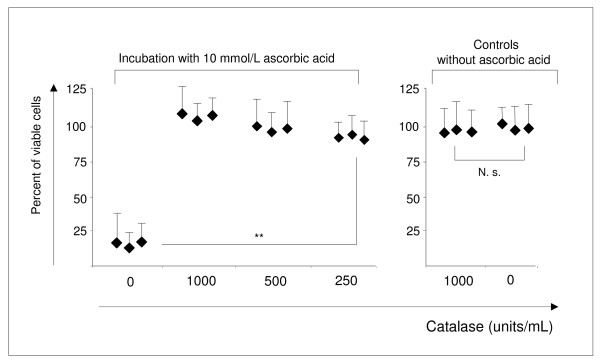
The hydrogen peroxide scavenger catalase prevents the cytotoxic effect of ascorbic acid-mediated hydrogen peroxide production. The addition of exogenous catalase to cells of the U-251 cell line incubated with toxic concentrations of ascorbic acid (10 mmol/L) prevented the lethal effect elicited by ascorbic acid. U-251 cells incubated with catalase alone were not affected in their viability. The results shown are representative for 3 independent analyses and values are expressed as mean ± standard deviation of hexaplicates. The difference between 0 and 250 units/mL catalase is significant (p = 0.004). N.s.: not significant.